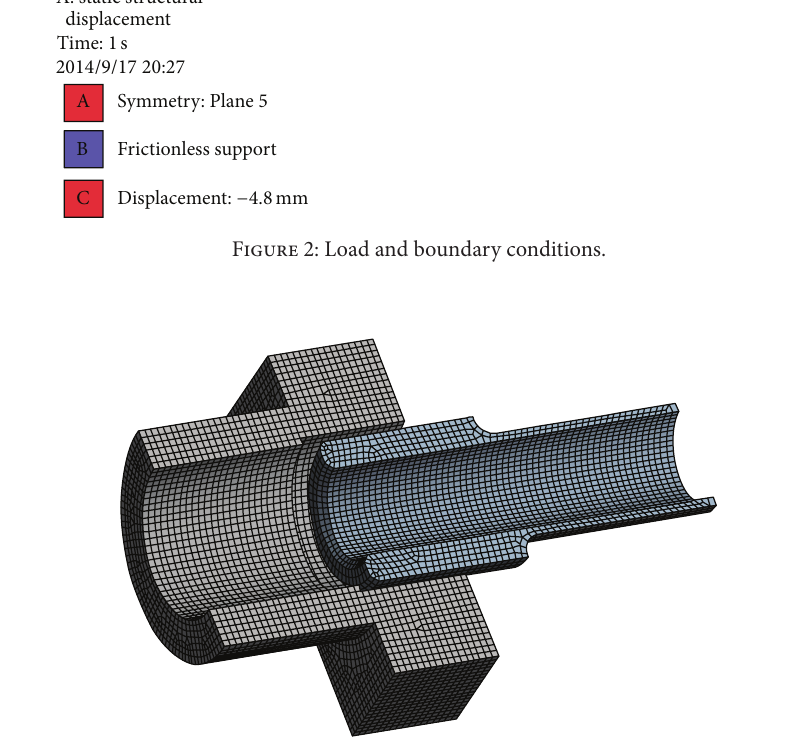
Figure 3: Finite element method model of 1/2 microparts.